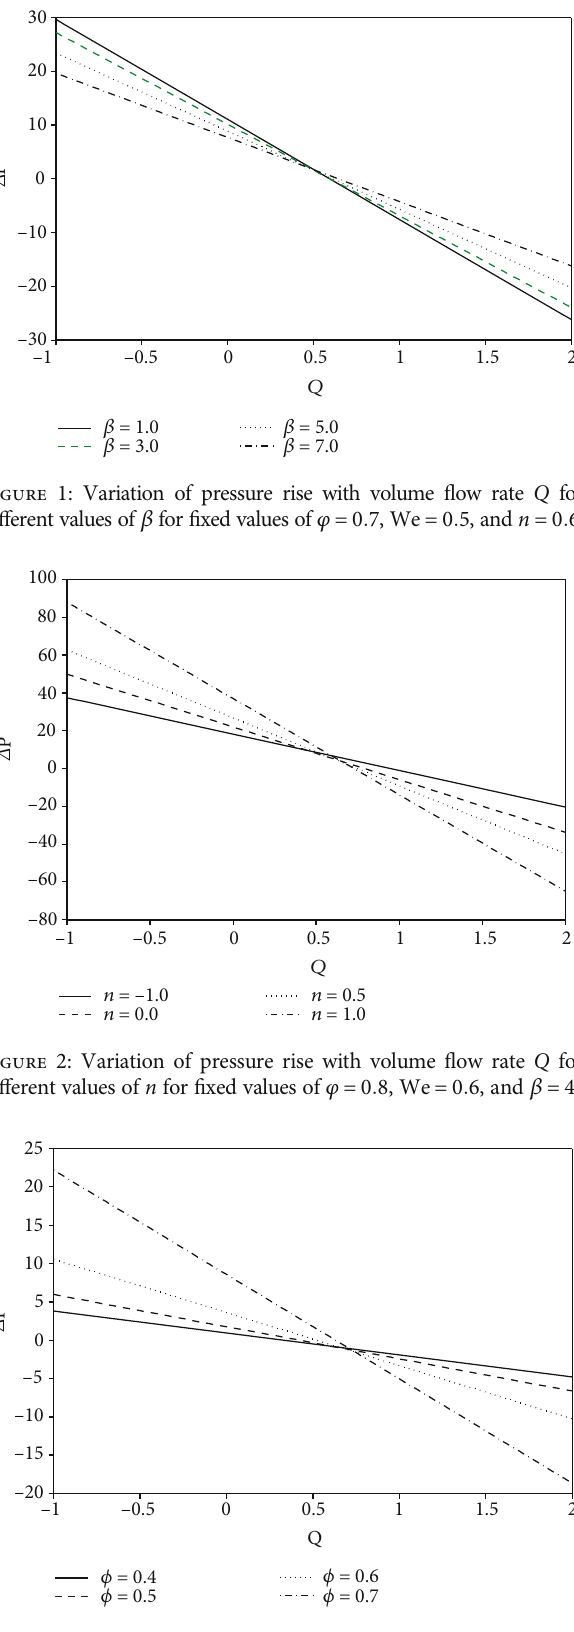
Figure 3: Variation of pressure rise with volume fl ow rate Q for di ff erent values of φ for fi xed values of n = 0 : 5 , We = 0 : 6 , and β = 4